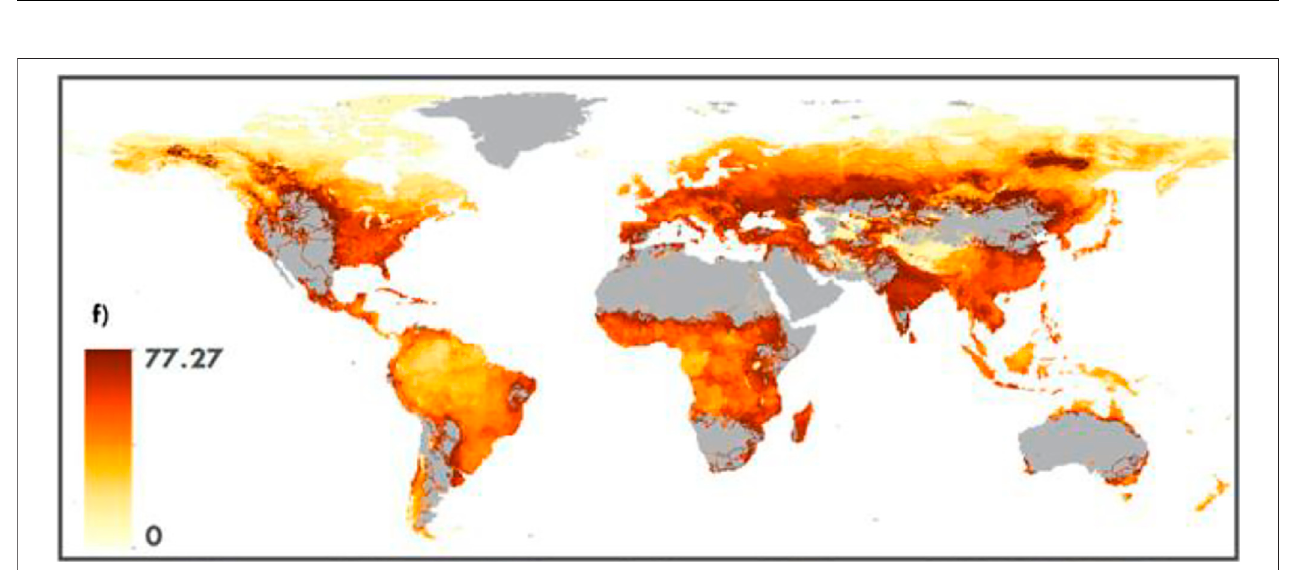
FIGURE 9 | Wildlife-Water Risk index globally. Red areas have higher risks. Areas in gray were excluded from the analysis because of low precipitation and/or runoff – see Figure 10 for comparison. (Robinne et al., 2020, Reprinted by permission).